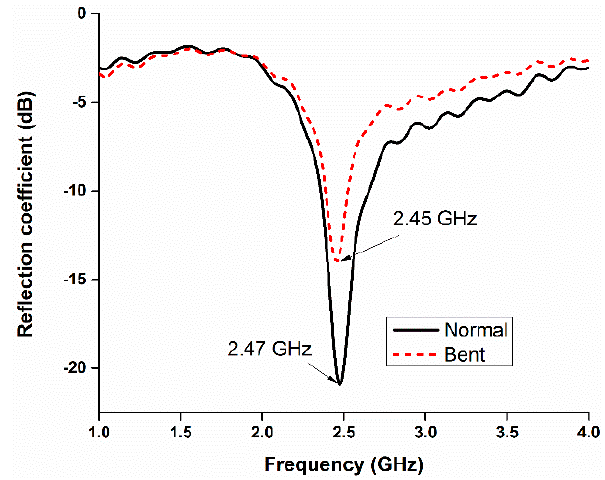
Figure 8. Reflection coefficients during normal and bent conditions.